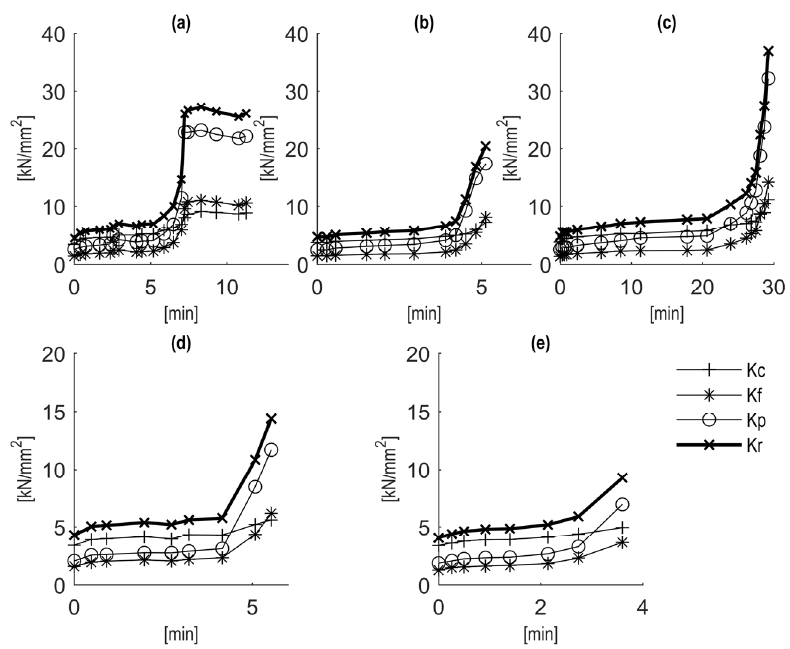
Figure 6. Specific force components vs machining time with the TS2000 tool supplied by Seco for different cutting conditions: ( a ) V = 50 m/min; f = 0.1 mm/rev; ( b ) V = 50 m/min; f = 0.15 mm/rev; and ( c ) V = 35 m/min; f = 0.1 mm/rev; ( d ) V = 50 m/min; f = 0.1 mm/rev; and ( e ) V = 50 m/min; f = 0.15 mm/rev. Depth of cut was 0.25mm for ( a – c ) and 0.5mm for ( d , e ).